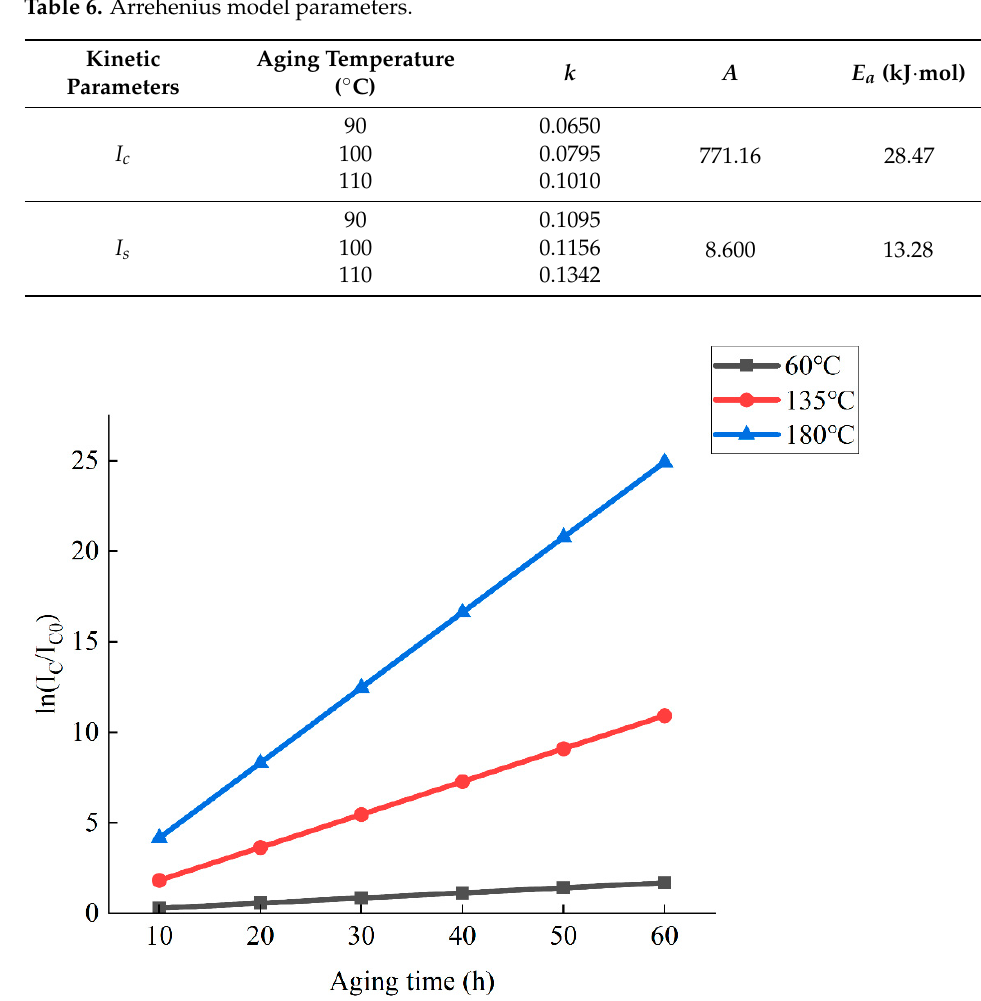
Table 6. Arrehenius model parameters.